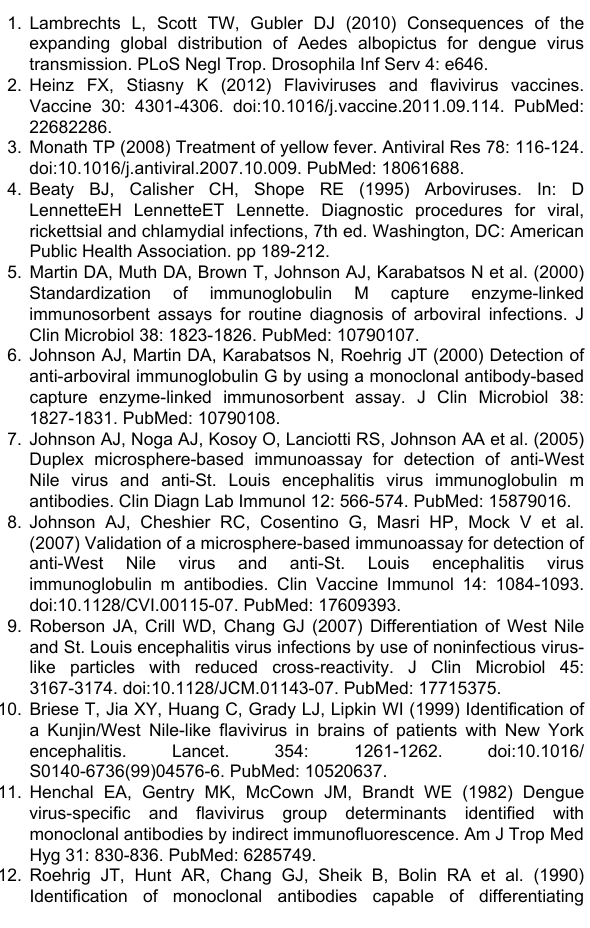
Table S1. Multiplex results for summer 2011 samples with indeterminate or unconfirmed diagnostic IgM results.